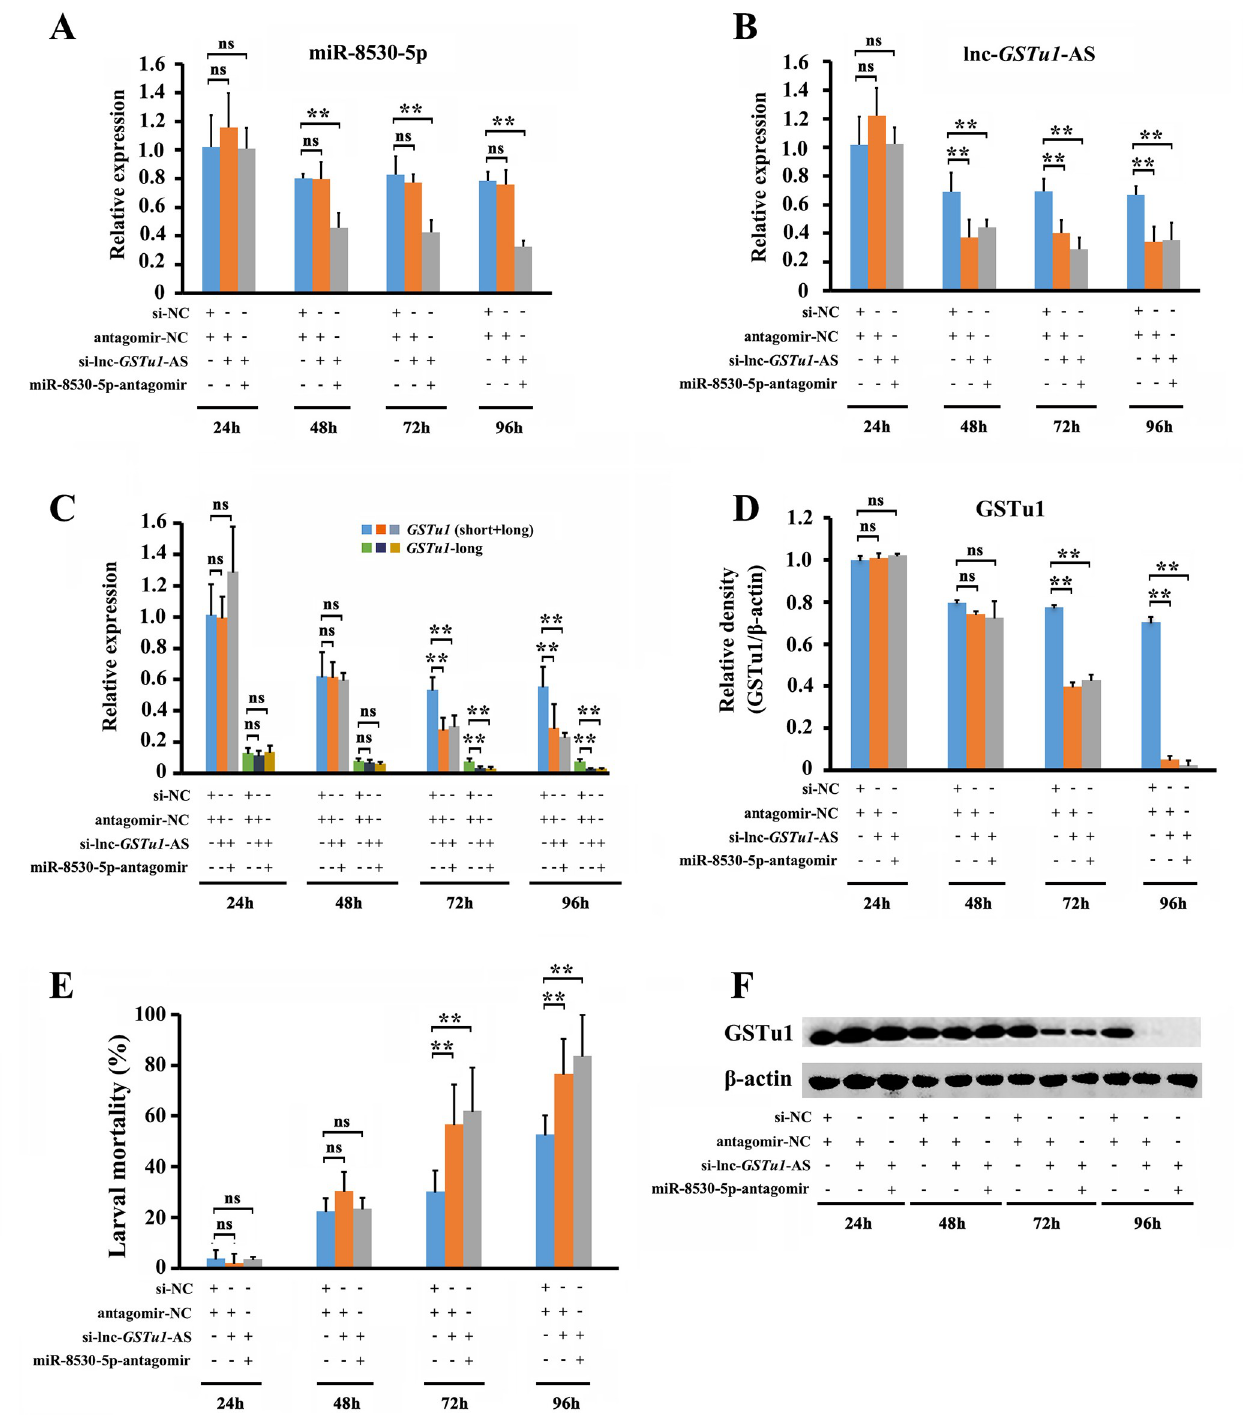
Fig 8. miR-8530-5p is not involved in the regulation of GSTu1 by lnc- GSTu1 -AS. Relative expression of miR-8530-5p (A) and lnc- GSTu1 -AS (B) after inhibition of miR-8530-5p and knockdown of lnc- GSTu1 -AS. C: Relative expression of GSTu1 after inhibition of miR-8530-5p and knockdown of lnc- GSTu1 -AS by qRT-PCR (C) and Western blot assay (D, F). E: Mortality of P . xylostella treated with the LC 50 of chlorantraniliprole. Asterisks indicate significant differences between the treatment and the corresponding control (Student’s t -test, ns indicates no significant differences, � 0.01 < P < 0.05, �� P <